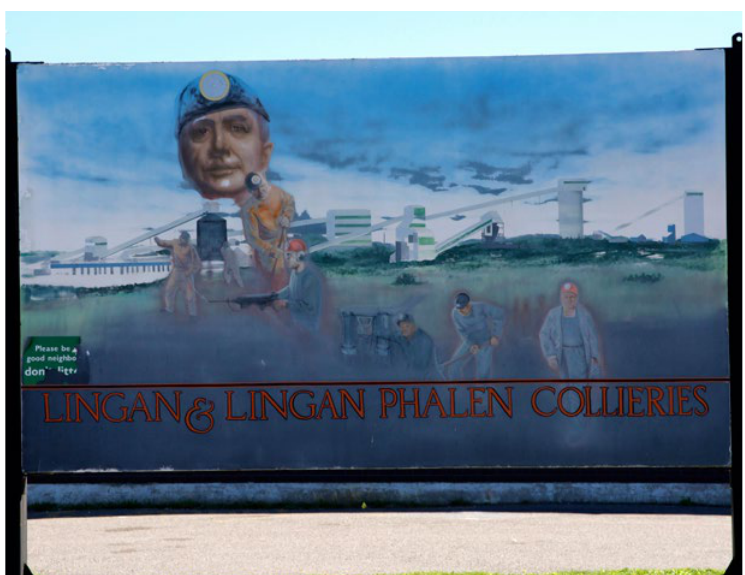
Figure 8. Number 17 colliery